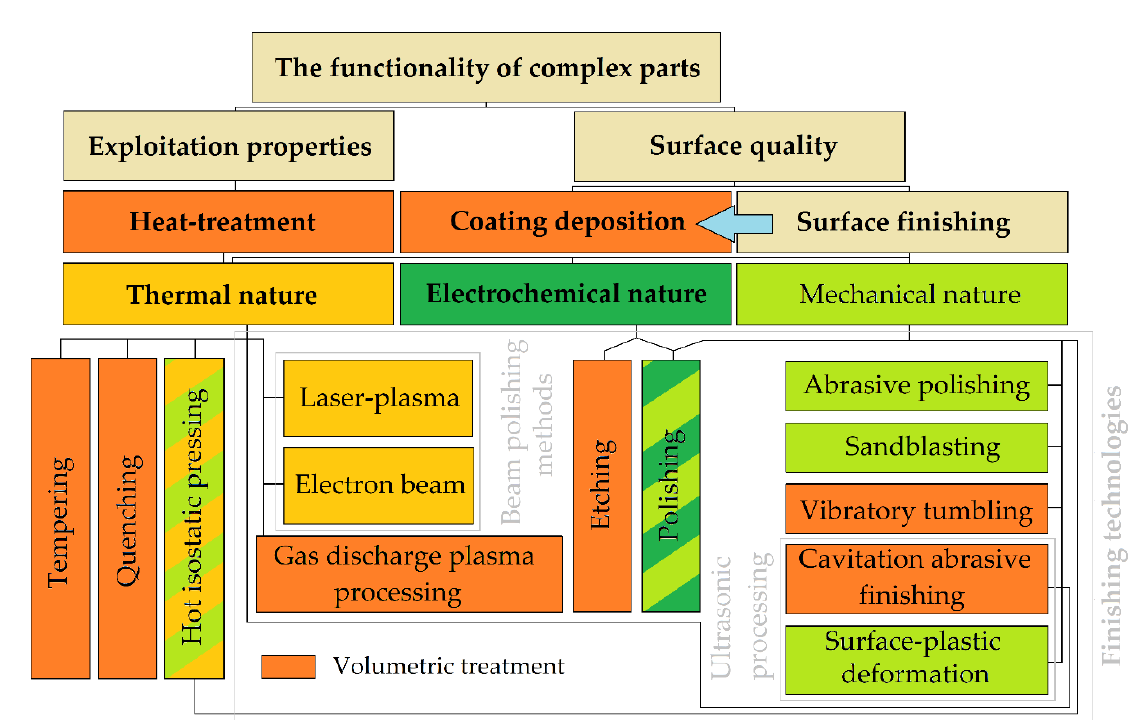
Figure 2. Technologies’ classification improving the exploitation properties and surface quality of the complex parts produced by additive manufacturing based on its nature.